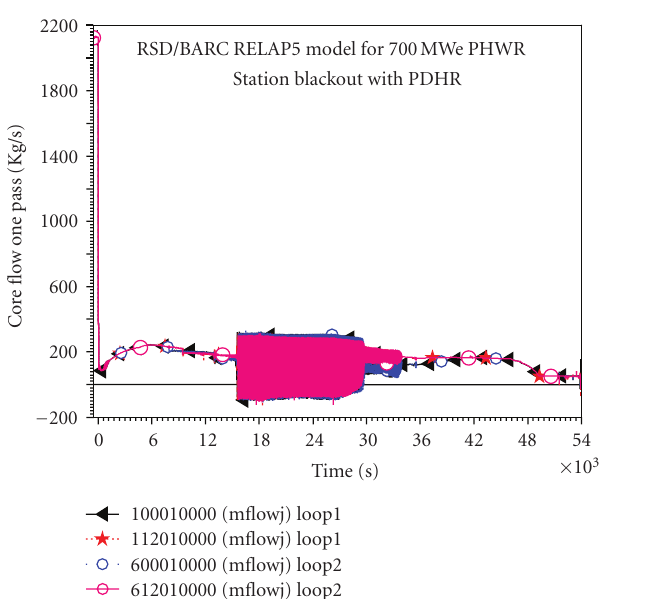
Figure 11: Core flow variation case-6 minutes delay in valving in PDHRS.